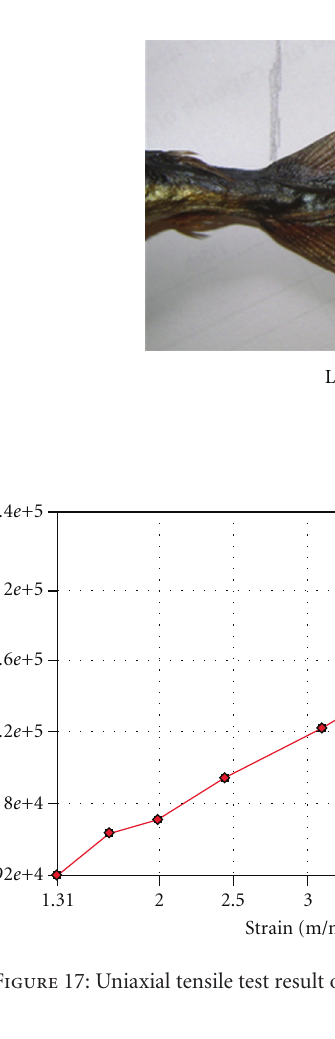
And for the rubber material, the data are uniaxial (Figure 17) and biaxial (Figure 18) test